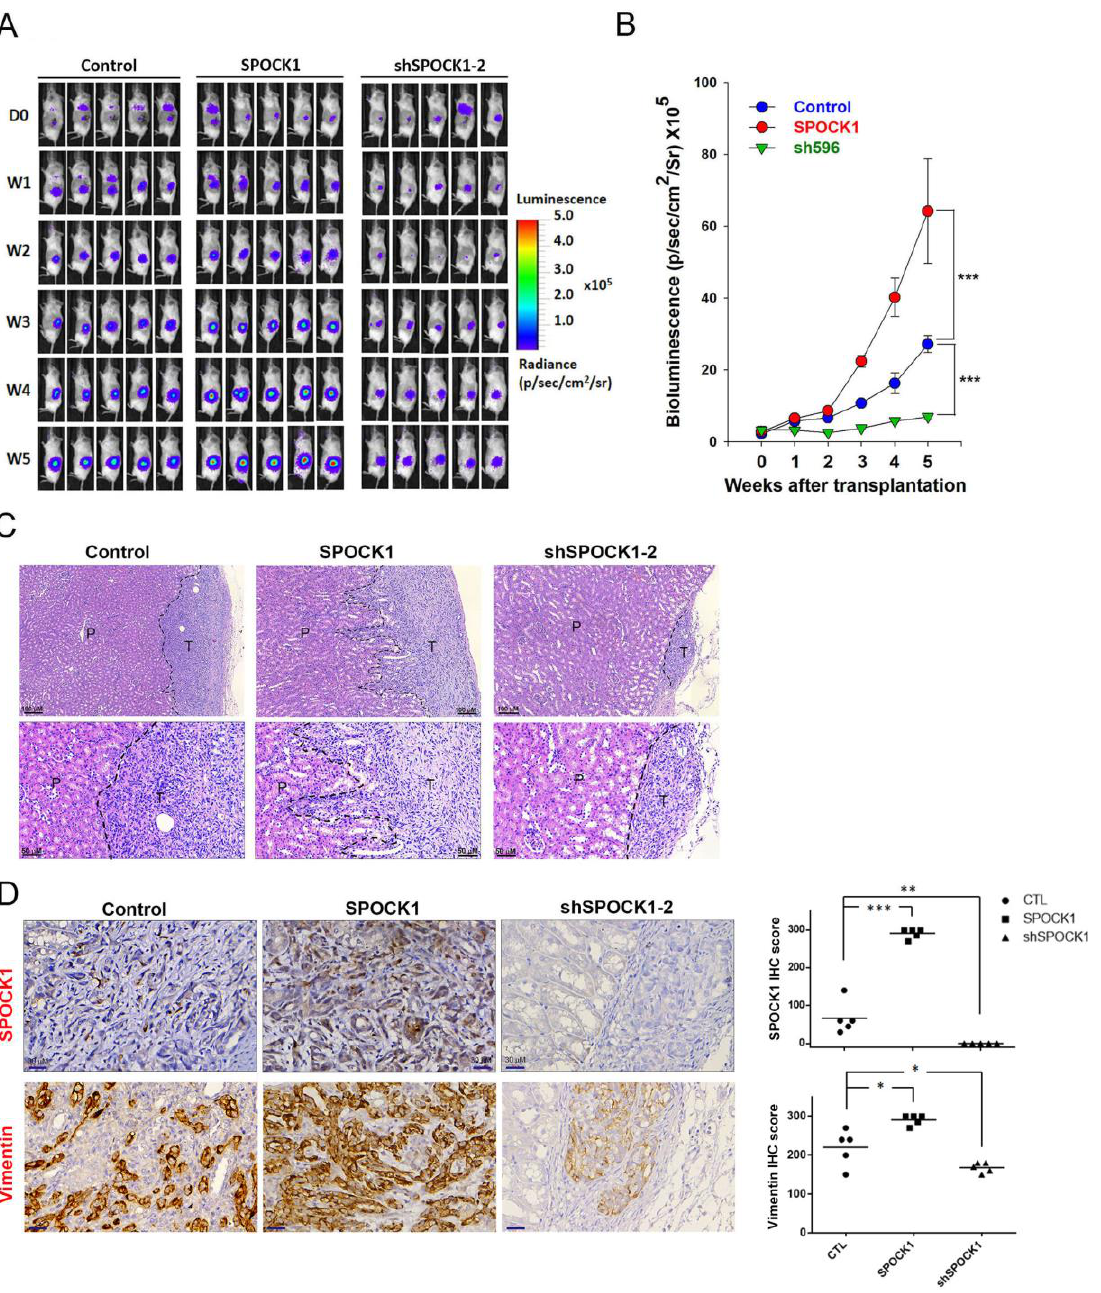
Figure 6. SPOCK1 regulates tumorigenicity and invasive ability in vivo. ( A ) Luciferase − tagged Cak − 1 cells with stable SPOCK1 − KD or overexpression were implanted into kidneys of NOD/SCID mice. Luciferase activity was detected at indicated time points with an IVIS imaging system. Repre- sentative bioluminescent images of mice from the control, SPOCK1 − overexpression, and SPOCK1 − KD groups taken per week are shown. ( B ) Quantitative analysis of Xenogen imaging sig- nal intensity (photons/s/cm 2 /sr) every week. ( C ) The H&E staining of orthotopically implanted tu- mors shows the interface between the generated murine tumor and renal parenchyma. At the end of the study, tumor-injected kidneys were isolated and examined by the H&E staining. The interface between the generated murine tumor and renal parenchyma is indicated by the black dashed line, and parenchyma infiltration was observed in tumor cells overexpressing SPOCK1. Scale bar = 50 or 100 µm. ( D ) SPOCK1 and vimentin protein expression levels in Caki-1 orthotopic tumors expressing SPOCK1 or shSPOCK1 were measured by IHC staining. Scale bar = 30 µm. Right panel, quantifica- tion of the SPOCK1 and vimentin IHC staining score. * p < 0.05, ** p < 0.01, *** p < 0.001, compared to the control group.